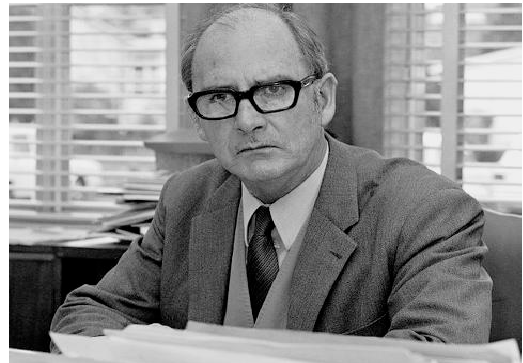
Figure 9. John Frederick Cade (1912–1980), authentic pioneer of modern psychopharmacology with his experiments on lithium.